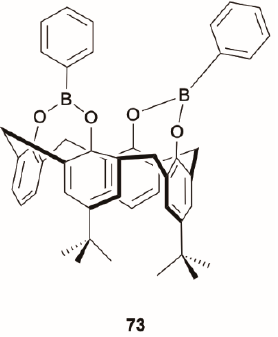
28 of 45 Figure 19. Absorption (white) and emission (gray) features for 71 ( top ) and 72 ( bottom ) in DCM. Reprinted with permission from [71], Copyright 2014, American Chemical Society. Bis(bora)calix[4]arene, 73 (Scheme 26), was reported by Arimori et al. [72] as a fluo- rescent sensor selective for fluoride due to a decrease in UV absorption and fluorescence upon F − binding. In 2016, Jin et al. [73] performed a thorough DFT/TDDFT study to